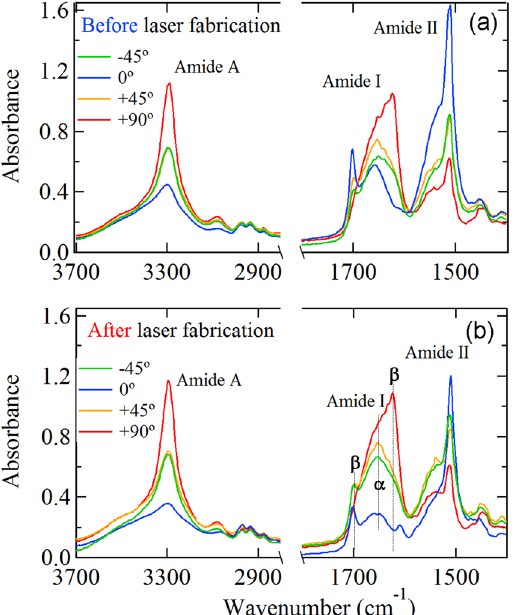
Figure 3. Polarisation discriminated absorbance spectra of pristine ( a ) and laser 515 nm/230 fs irradiated ( b ) silk fiber; laser pulse energy was 8.5 nJ and pulse-to-pulse separation of 2 μ m in xy-array. Area of laser patterning was 10 × 10 μ m 2 ; IR beam diameter at focus on the sample was 4.2 μ